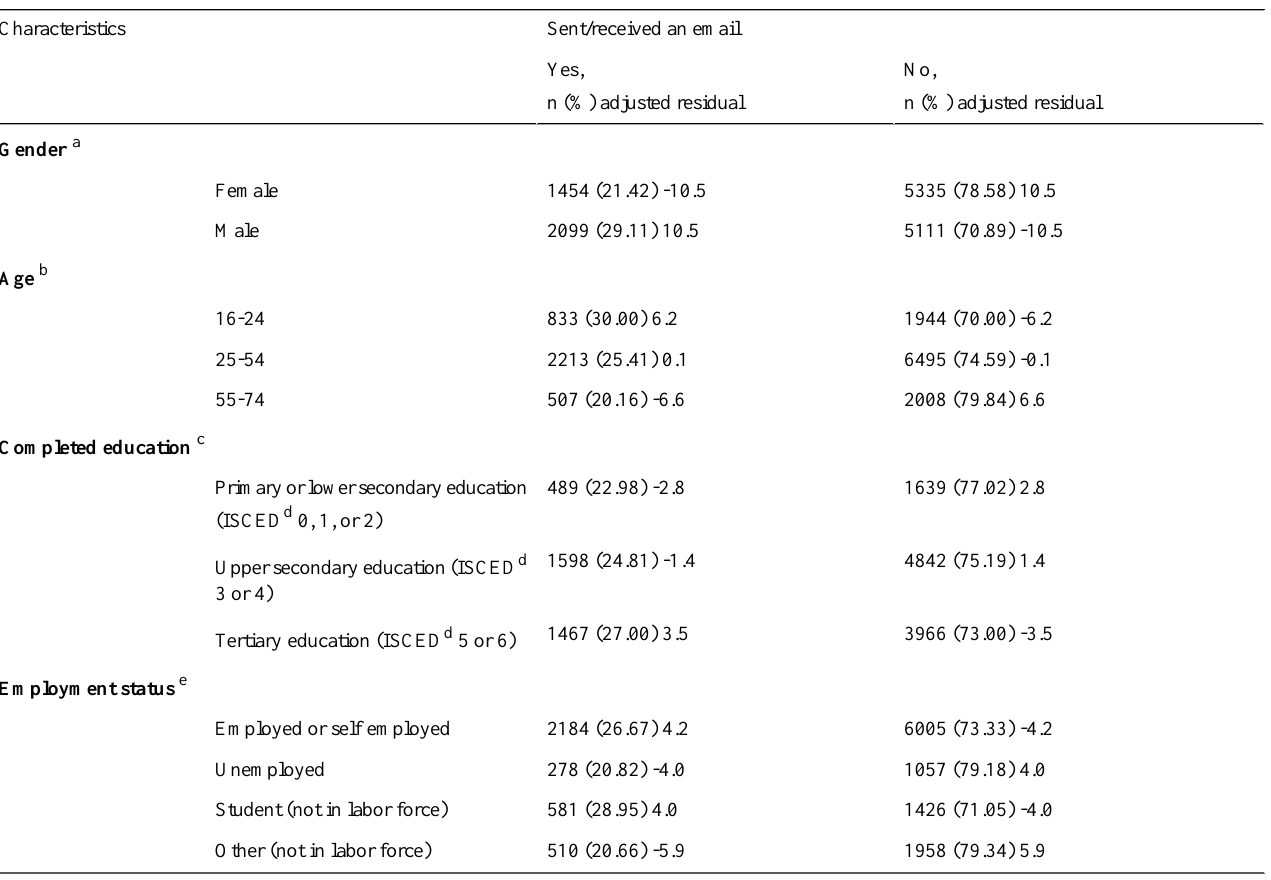
Table 5. Sent/received an email from your doctor, nurse, or health care organization, by demographic characteristic Sent/received an